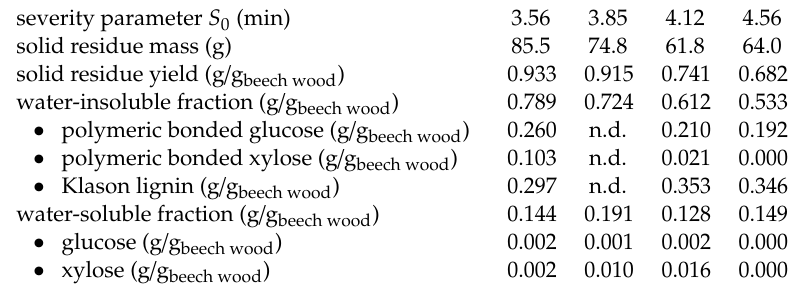
Table 2. Solid residues after steam explosion of beech wood at di ff erent severities, fractionation of solid residues is performed via Soxhlet extraction with water, n.d.: not